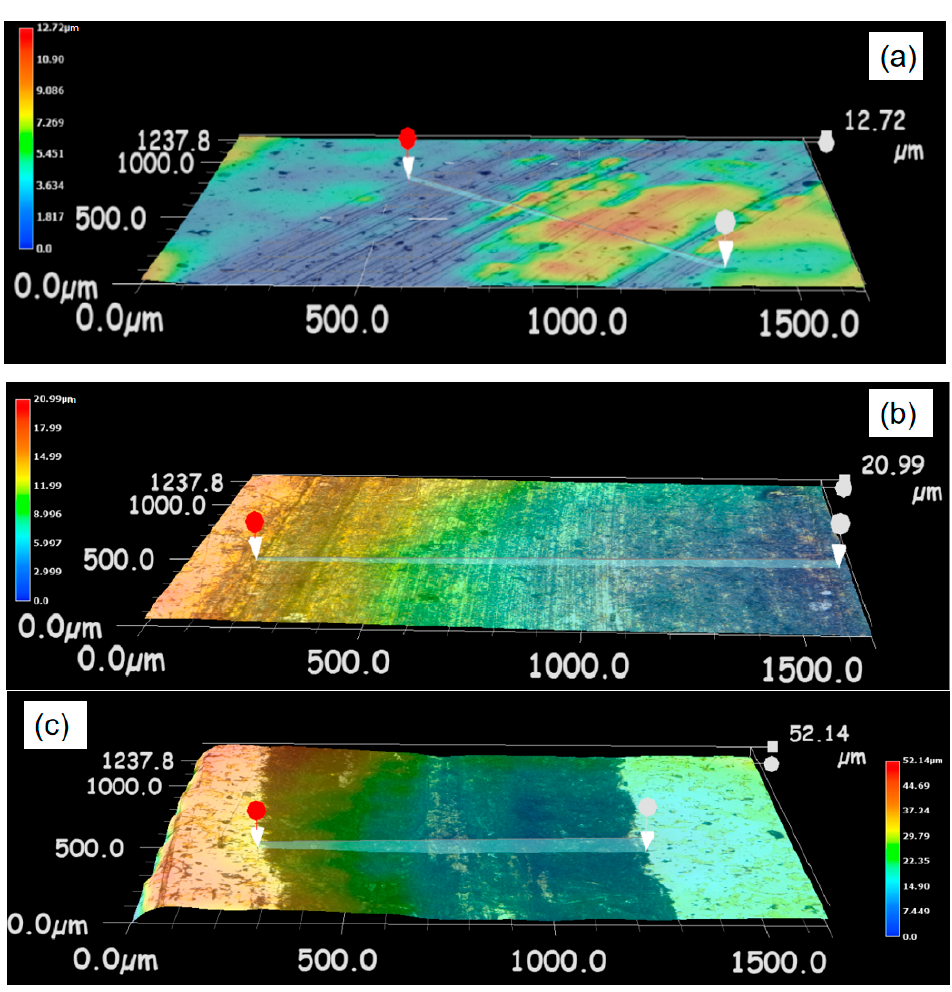
Figure 15. 3D morphologies of the worn surface of the coatings: ( a ) high-carbon steel coating; ( b ) composite coating; and ( c ) aluminum bronze coating.